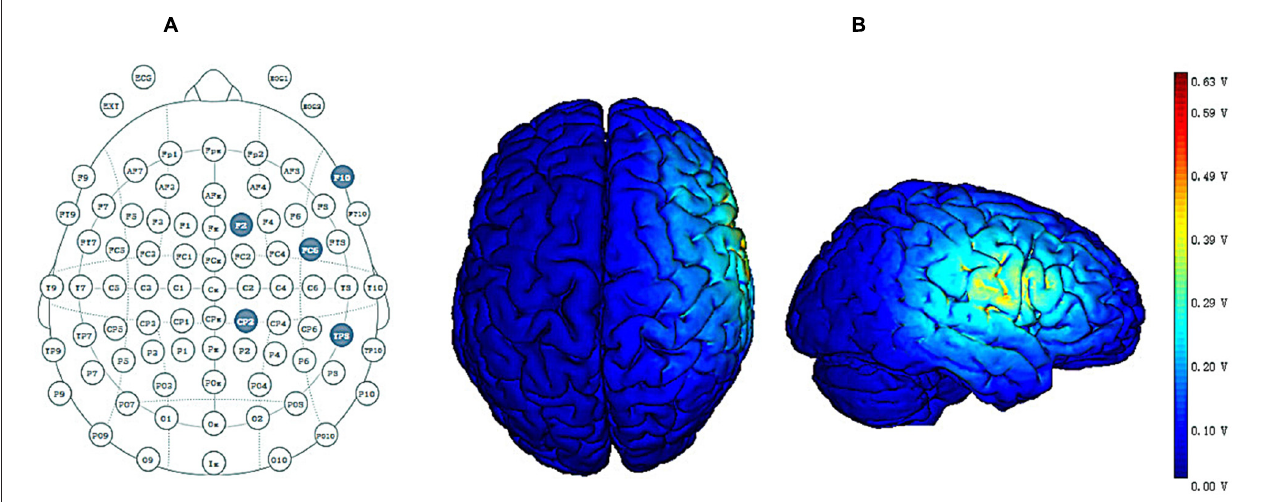
FIGURE 3 | Experimental design of the single-blind, within-subject and sham control trial.